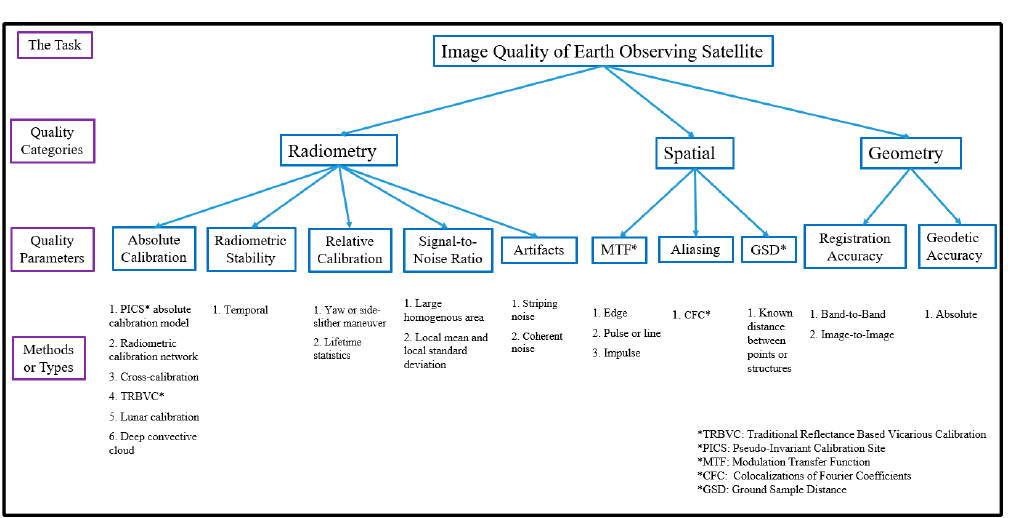
Figure 1. Outline of Earth-observing satellite image quality.